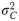
Predictions of BCV related to the compromise effect, involving option A, B and K.Here, in relation with option A, we assign Rp,A = 5 − d for price and Rq,A = 5 + d for quality; in relation with option B, we assign Rp,B = 5 + d for price and Rq,B = 5 − d for quality. The proximity parameter d varies across simulations from zero to four. To represent the option K with intermediate scores for both the two attributes, we assign Rp,K = 5 and Rq,K = 5 (100000 trials are simulated for each condition; σC2 = 1 for simulations). A: The difference in probability between choosing option K and option A during binary choice (P[K|A,K] − P[A|A,K]). The reward uncertainty σR2 is set to 0.1 and different values of the prior mean μC are considered. B: The same simulation is reported except that the reward uncertainty σR2 was set to one. C: The same simulation is reported except that the reward uncertainty σR2 was set to ten. D: The difference in probability between choosing option K and option A during choices in which option B is also available (P[K|A,B,K] − P[A|A,B,K]). The reward uncertainty σR2 is set to 0.1 and different values of the prior mean μC are considered. E: The same simulation is reported except that the reward uncertainty σR2 was set to one. F: The same simulation is reported except that the reward uncertainty σR2 was set to ten.